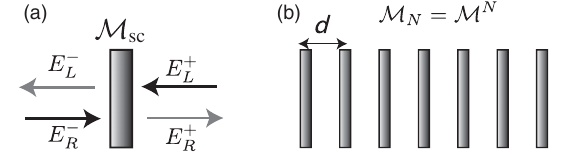
FIG. 19. (a) The transfer matrix M side and the other of the scatterer. The coefficients of M determined by imposing continuity on the fields. (b) For a periodic array of scatterers the total transfer matrix is simply the product of matrices M